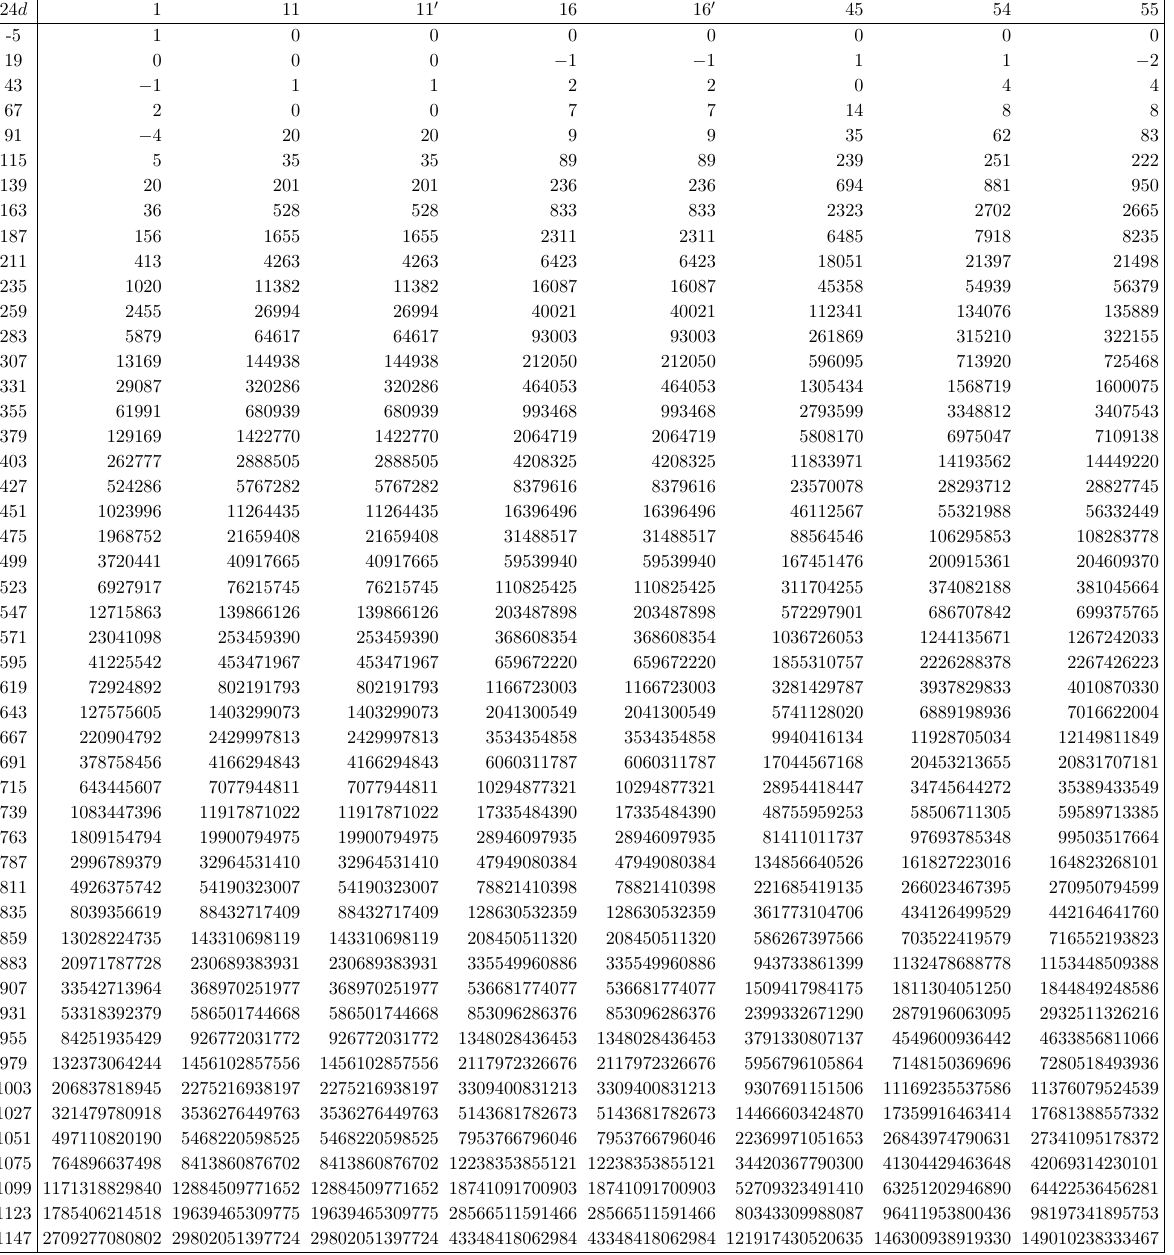
Table 4 . Multiplicity generating functions f (1)